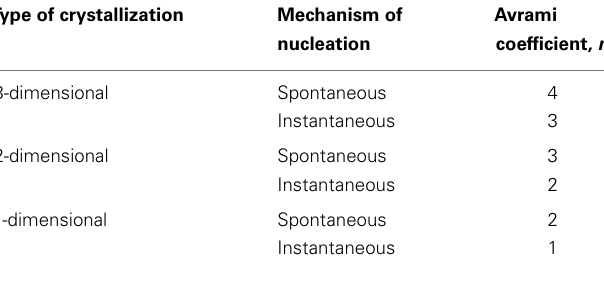
Table 3 |Theoretical values ofAvrami coefficients n (Sperling, 1992)